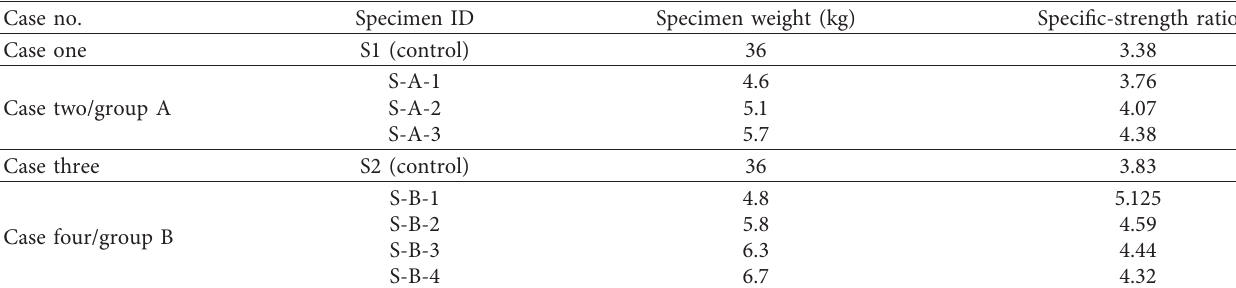
Figure 14: Load-deflection for all specimens. (a) Load-deflection (S-A-1). (b) Load-deflection (S-A-2). (c) Load-deflection (S-A-3). (d) Load-deflection (S-B-1). (e) Load-deflection (S-B-2). (f) Load-deflection (S-B-3). (g) Load-deflection (S-B-4). Table 5: Specific strength ratio results for tested